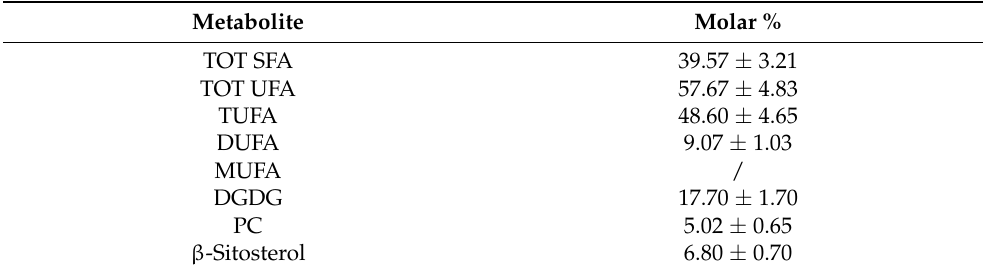
Table 6. Quantitative NMR results for some metabolites present in the Bligh-Dyer organic extracts of BL1 Goji leaves. Results were expressed as molar % ±